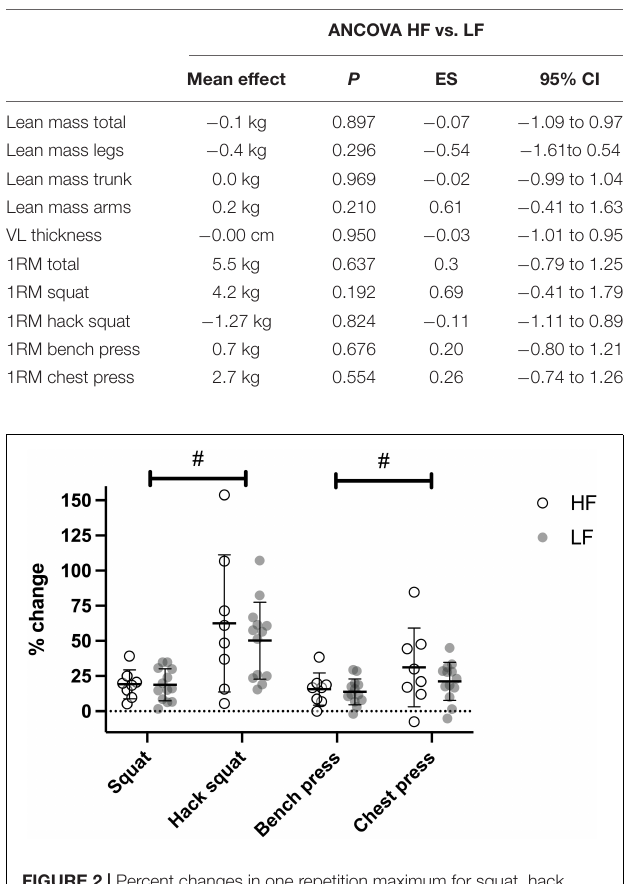
TABLE 2 | Comparisons between groups are based on estimated marginal means.